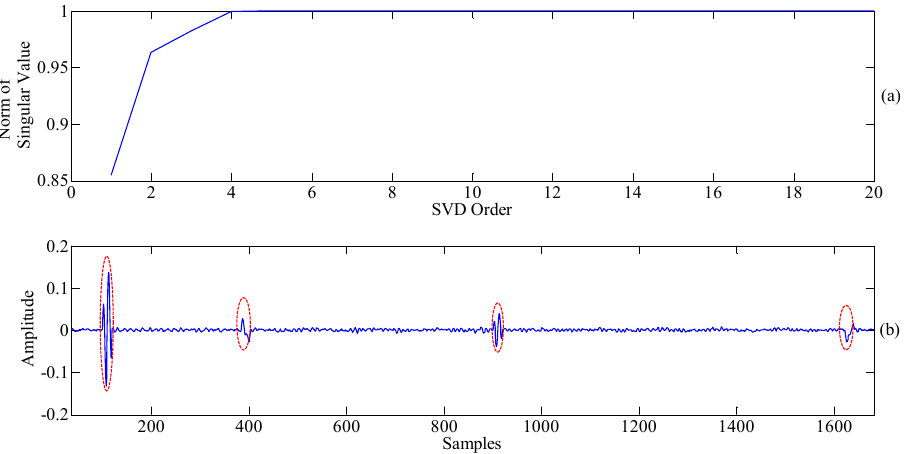
Figure 5. Detection of catastrophe points in signal described by Equation (18). ( a ) Norm of singular value; ( b ) The waveform of P 5 .